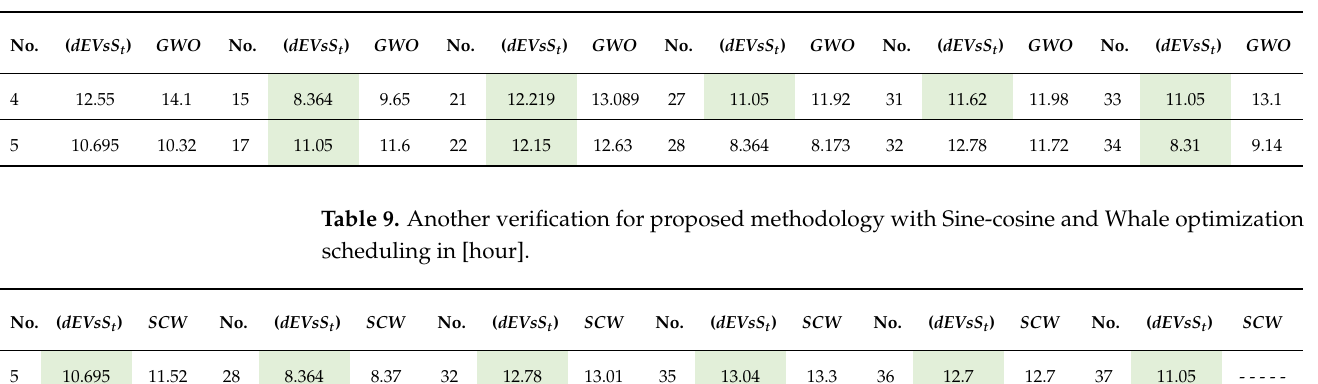
Table 8. Another verification for proposed methodology with GWO scheduling in [hour].